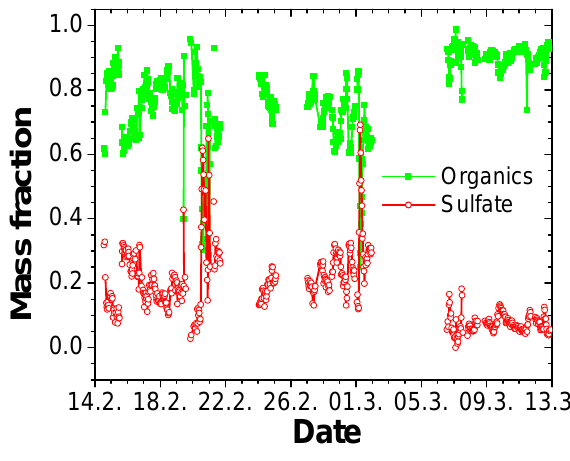
Fig. 12. Time series of organic and sulfate mass fractions deter- mined by integral AMS measurements, averaged over correspond- Fig. 12: Time series of organic and sulfate mass fractions determined by integral AMS measurements, averaged over ing CCN measurement intervals, and plotted against the date in corresponding CCN measurement intervals, and plotted against the date in Feb-Mar 2008 (UTC). February–March 2008